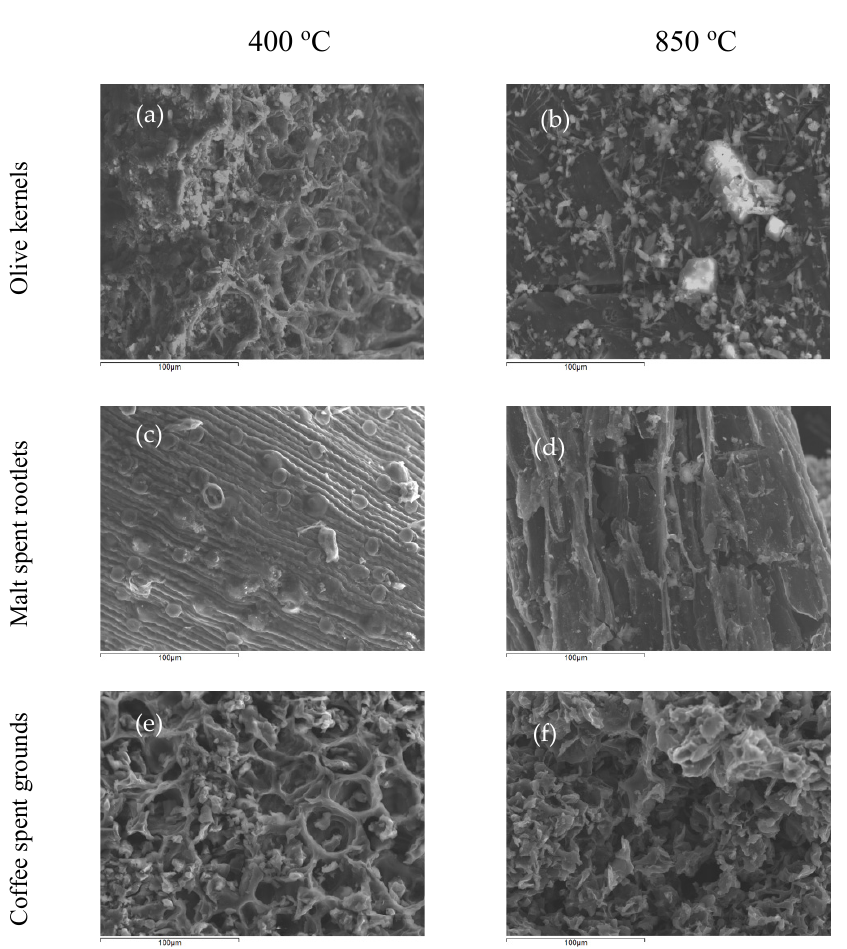
Figure 1. SEM images of the prepared biochars: ( a ) OK400, ( b ) OK850, ( c ) MSR400, ( d ) MSR850, ( e ) CSG400, and ( f ) CSG850. Table 1. Atomic content (%) of elements of the studied biochars determined by the EDX analysis. Carbon was not used in the calculations. (N.D.: not detected) Element OK400